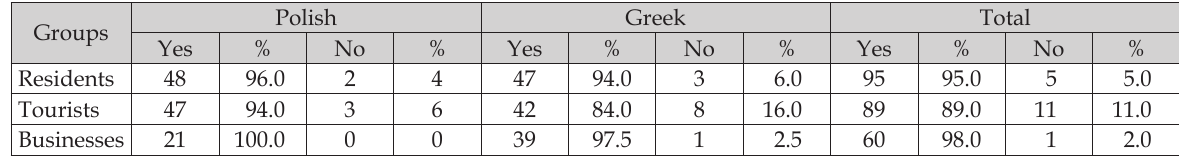
Table 2. Responses to the question: Can the landscape of Zwierzyniec/Chios be called a tourist landscape? Groups